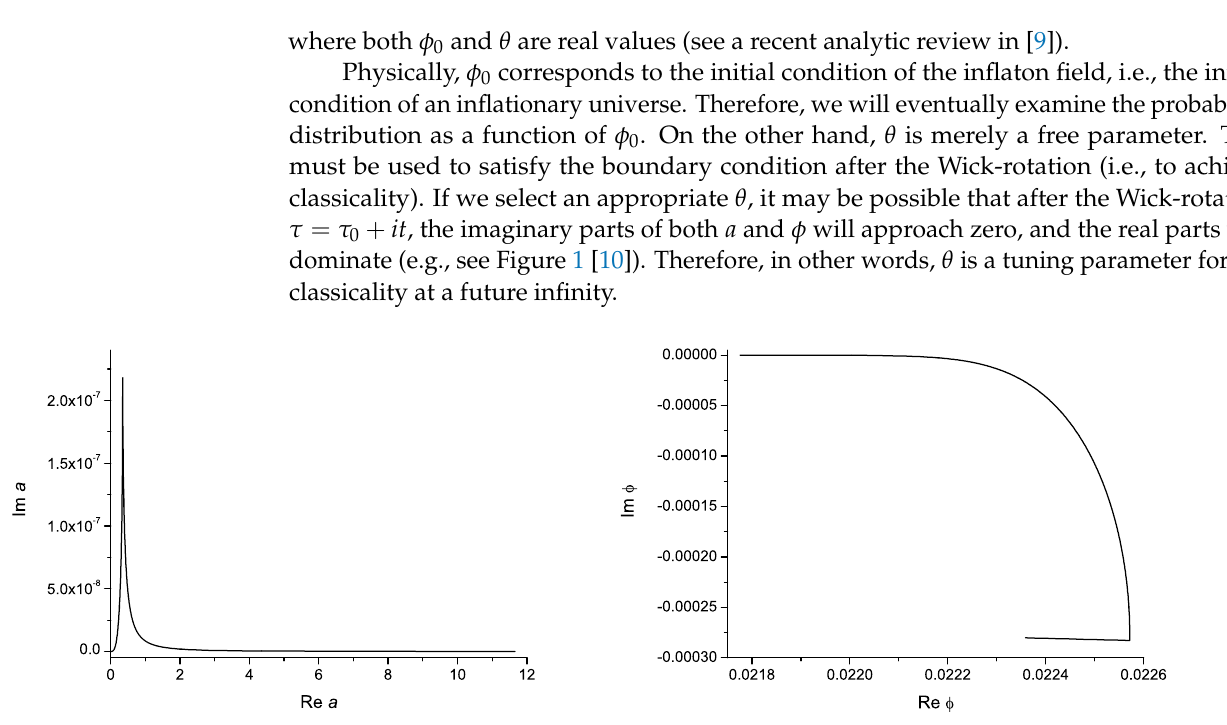
√ V 0 = 0.02, where the left side is the metric a ,